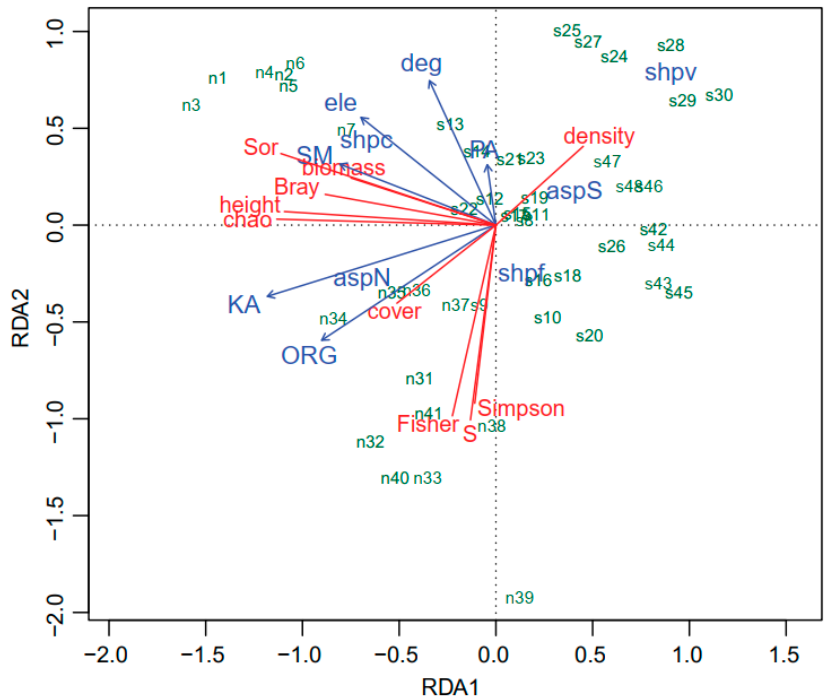
Figure 4. Redundancy analysis (RDA) of vegetation structure on environmental variables on the first two canonical axes. (Sor, Sorensen; Bray, Bray-Curtis; ORG, organic matter; PA, available phosphorous; KA, available potassium; ele, elevation; aspN/S, north/south aspect; shpc/f/v, shape concave/flat/convex; deg, slope degree).